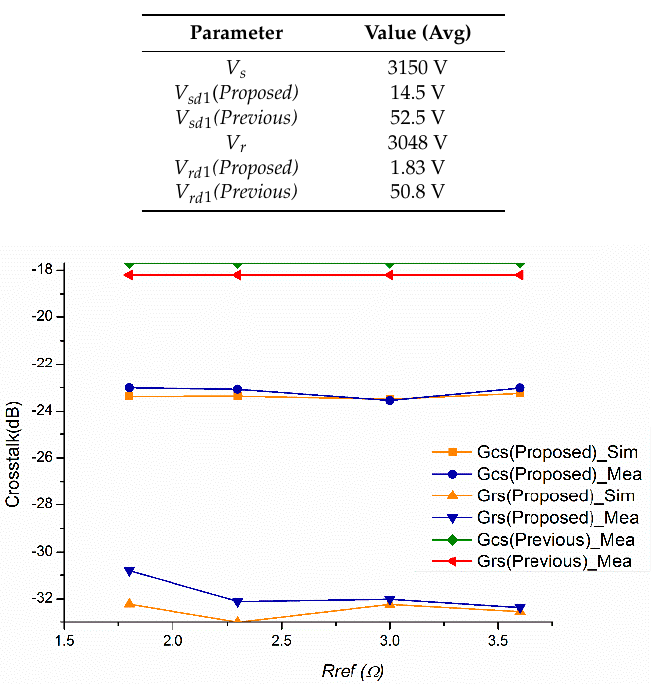
Table 2. Voltages measured at the power frequency.